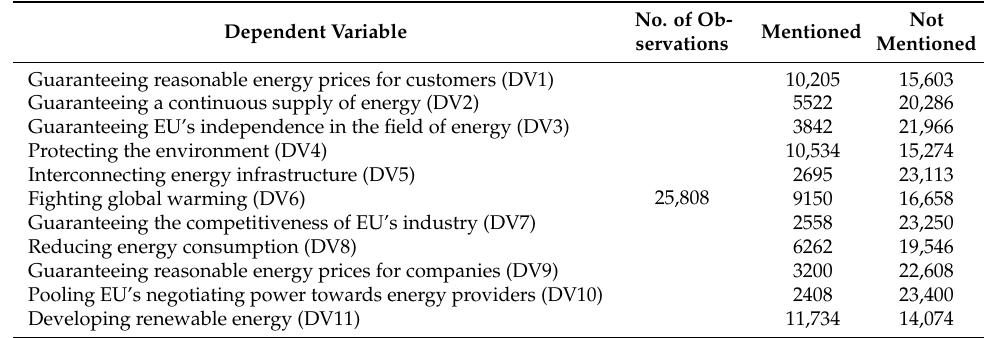
Table 1. Overview of dependent